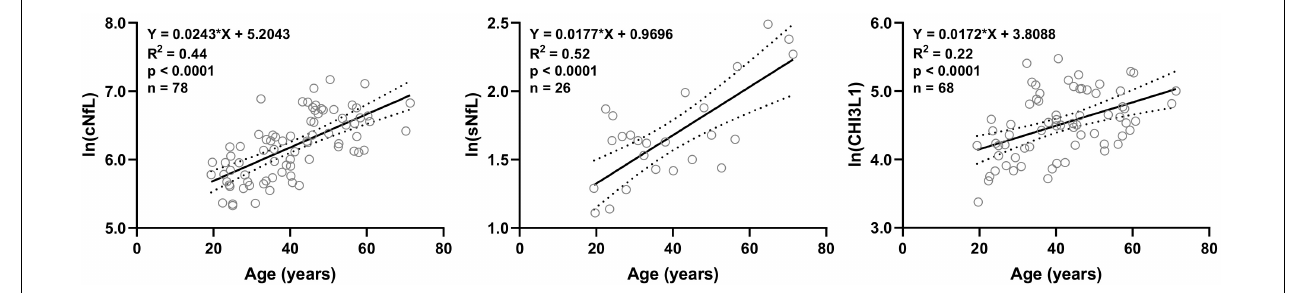
FIGURE 1 | In HD subjects’ research database, linear regression of CSF and serum NfL (cNfL and sNfL) and CHI3L1 with age as an independent variable was analyzed; All three biomarkers were significantly ( R 2 = 0.44, 0.52 and 0.22, respectively, and p < 0.0001) correlated with age.